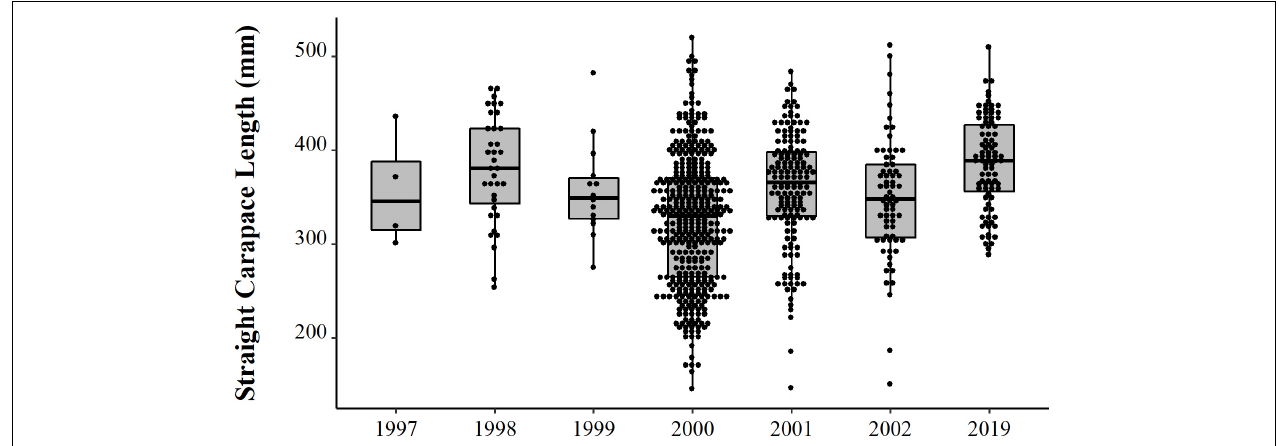
FIGURE 3 | Size distribution (points) and descriptive statistical (boxplot) of body size (SCL, mm) of big-headed ( Peltocephalus dumerilianus ) from the PNJ collected between 1997 and